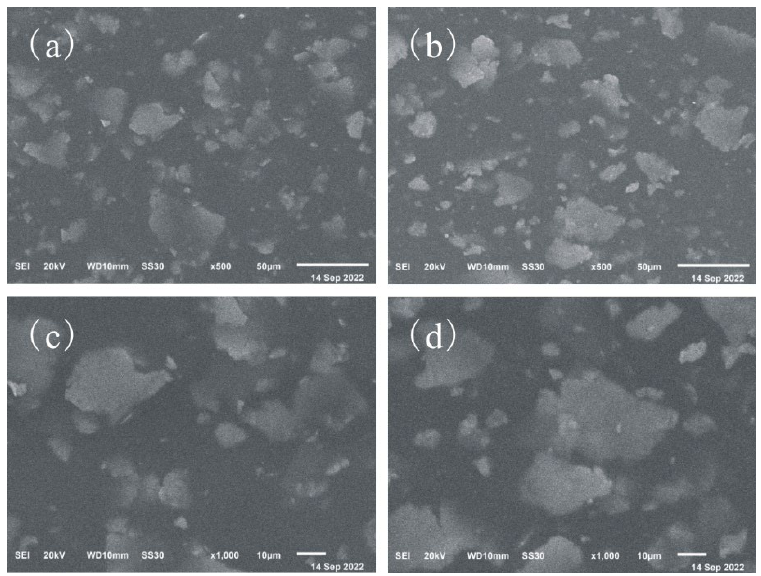
Figure 2. SEM photos of coatings under the mass ratios of epoxy resin to polyurethane of 2:8 ( a , c ) and 6:4 ( b , d ).